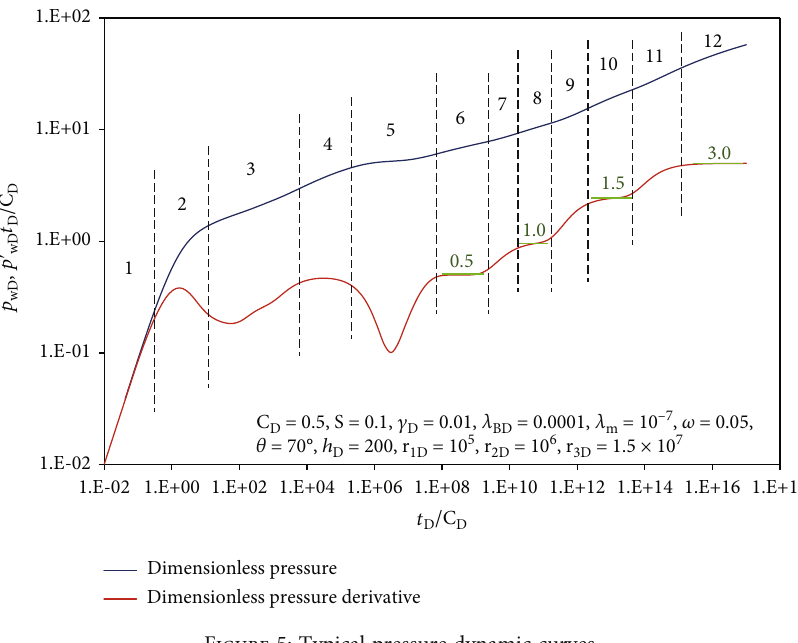
Figure 5: Typical pressure dynamic